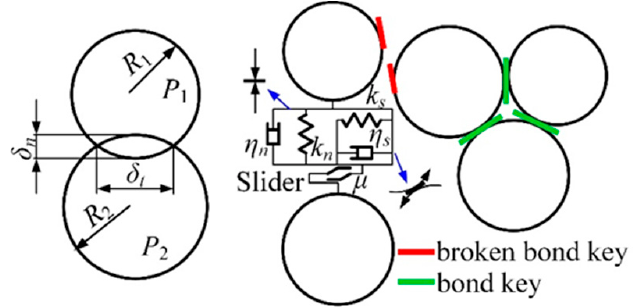
Figure 7. The contact model of particles in discrete-element method (DEM).